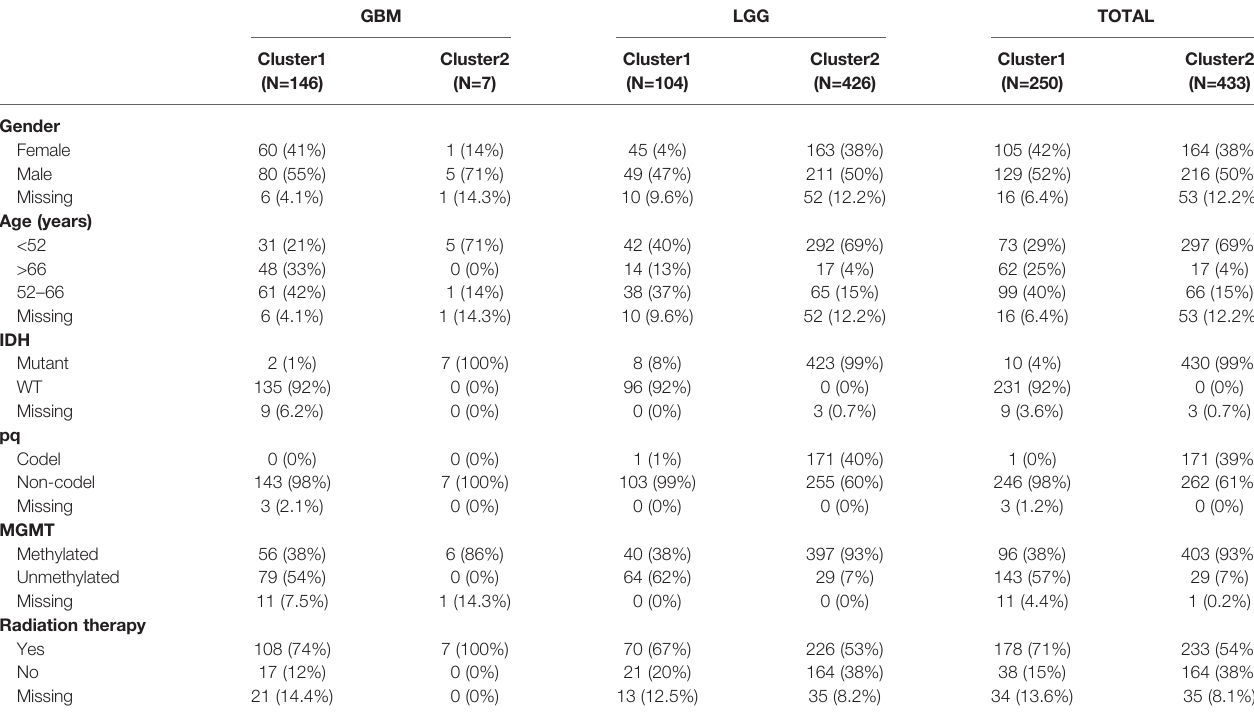
TABLE 1 | Clinical and genetic characteristics of patients after